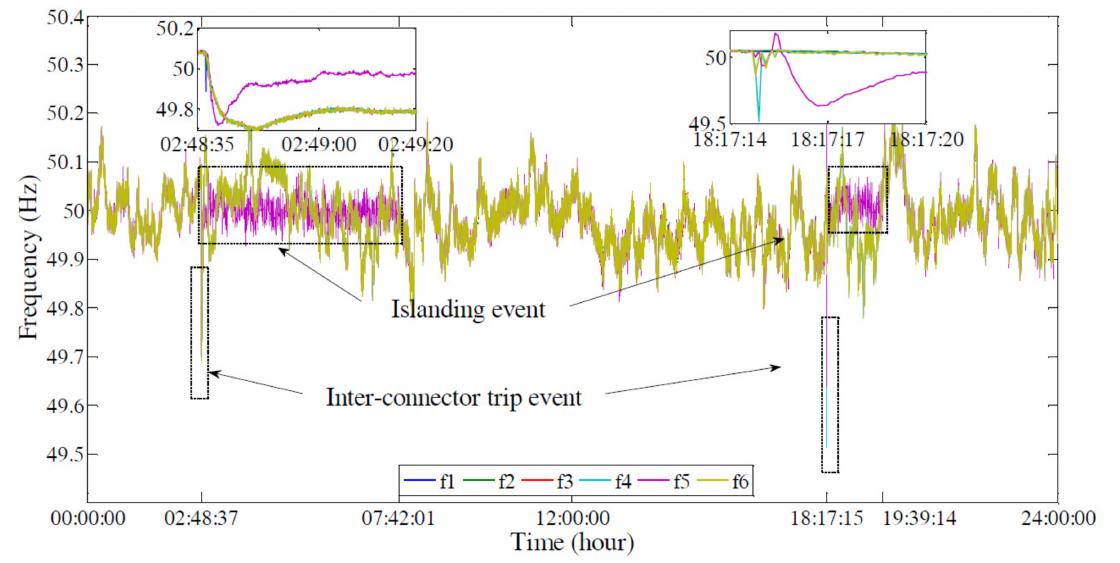
Figure 11. Frequency plot for detecting islanding events